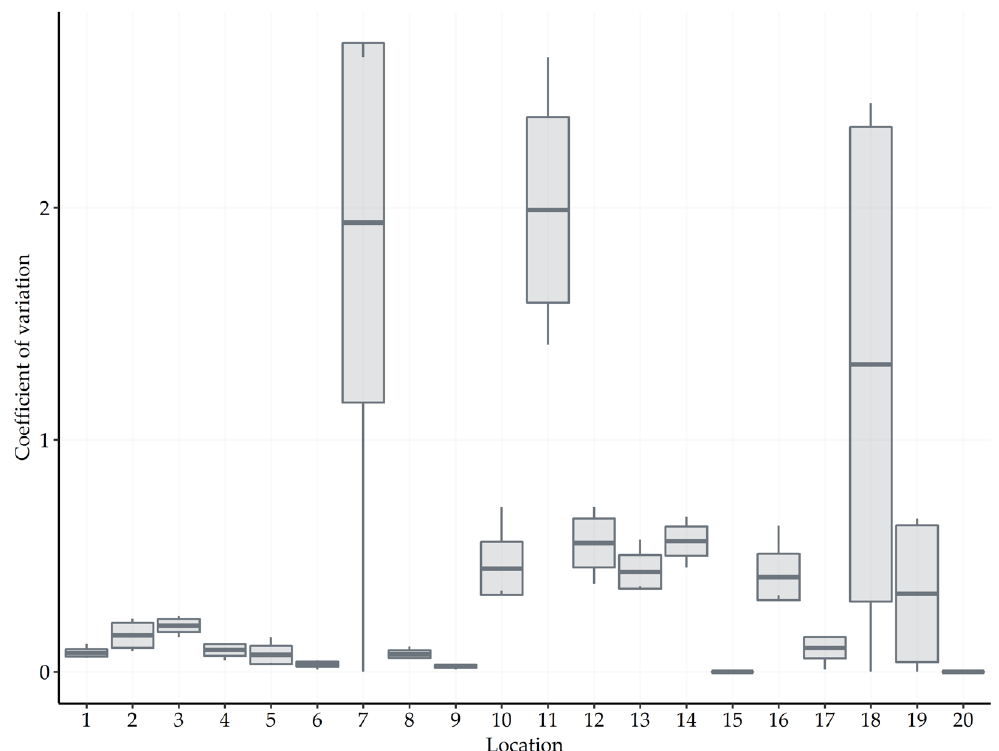
15 of 23 Figure 4. Bicycle traffic volumes of one simulation day in scenarios: ( a ) reference; ( b ) activity type choice; ( c ) target location choice; ( d ) starting time choice; ( e ) route choice. Due to the model’s stochasticity, it is important to check the uncertainty of results depending on the number of simulation runs. Experimental errors are represented as the coefficients of variations in bicycle traffic volumes at 20 random stations. In Figure 5, the